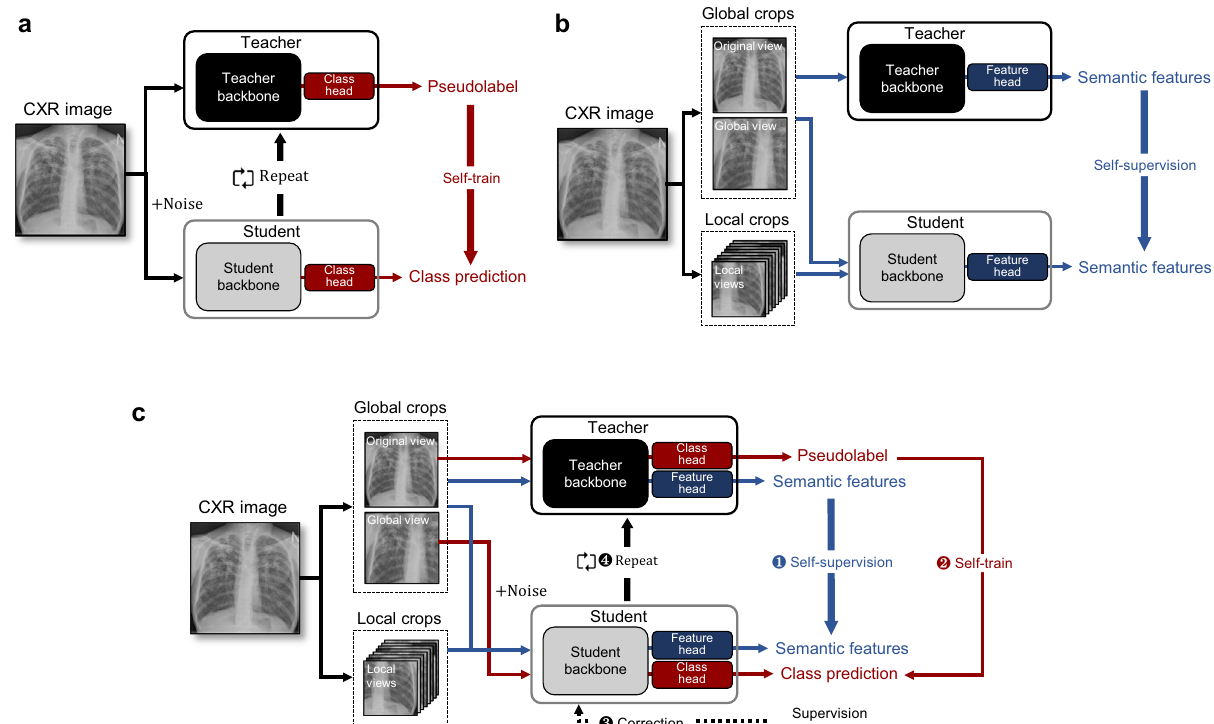
Fig. 1 Comparison between the existing methods and the proposed framework for the self-evolving AI model. a Self-training with noisy student method. b Self-supervised learning with distillation with no label (DINO) method. c The proposed distillation for self-supervised and self-train learning (DISTL) method is mainly composed of the two components, for self-supervision and self-training.